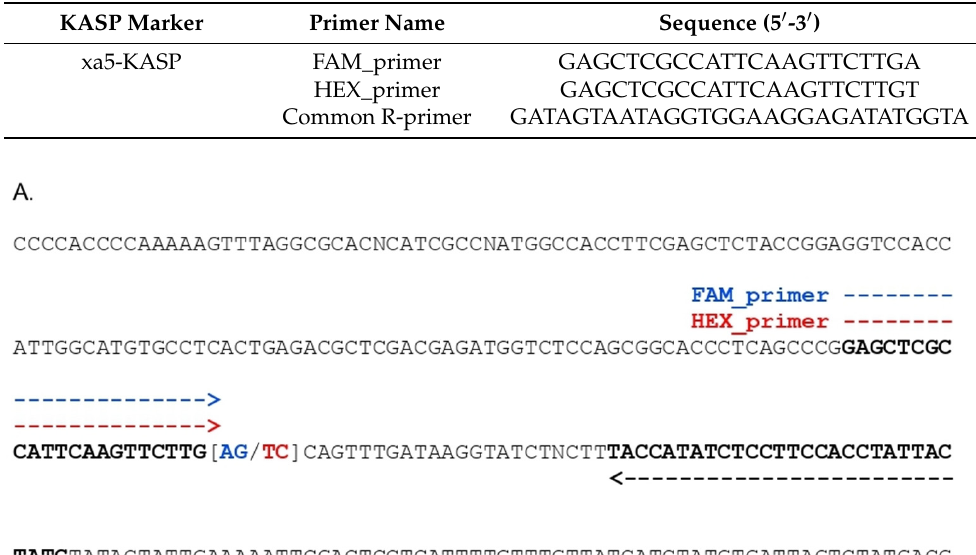
Figure 4. The xa5 -KASP marker’s development and validation. ( A ) Details on the locations of the selective KASP primers (FAM_primer and HEX_primer) and the common reverse primer. ( B ) Allelic discrimination plots of the PCR results of the xa5 -KASP markers genotyped in the F 2 population. Red dots represent the homozygous TC/TC genotype, blue dots represent the homozygous AG/AG genotype and green dots represent the heterozygous genotype. Table 5. Single-marker analysis of the xa5 -KASP marker on the 6 populations with Xoc isolate 2NY2-2. Cross Generation